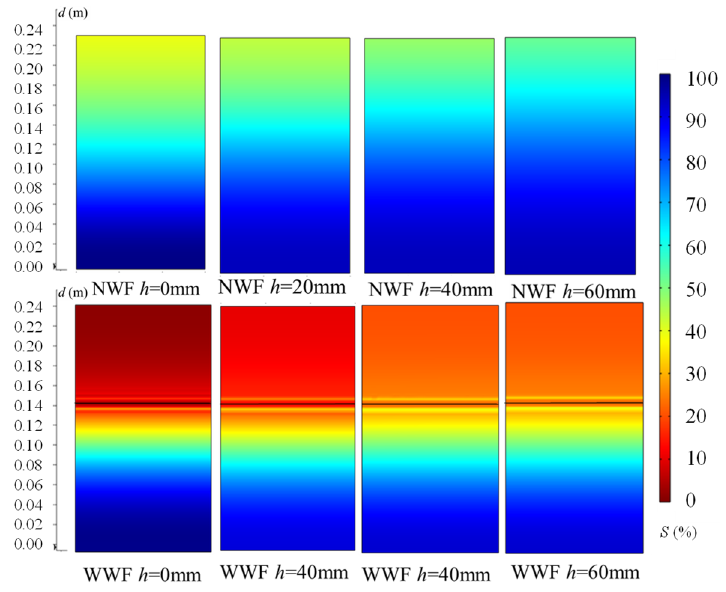
Figure 13. Contour plot of Effect of GWL on frost heave and WF inhibiting Figure 13. Effect of GWL on frost heave and WF inhibiting effect. Figure 13. Effect of GWL on frost heave and WF inhibiting effect.